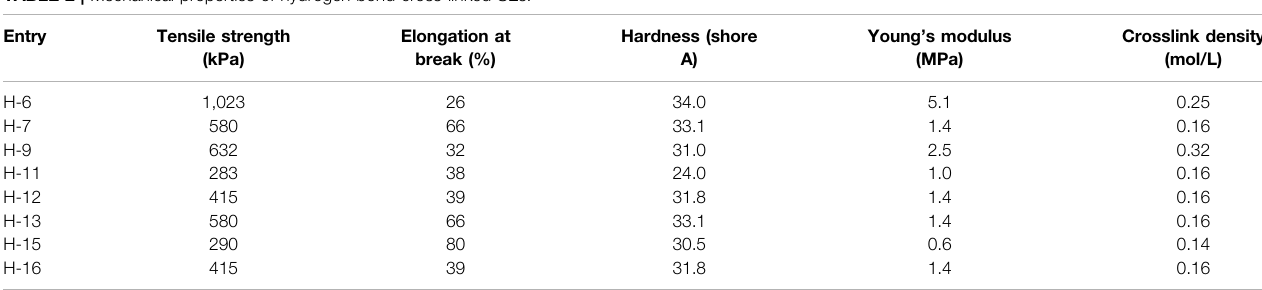
Table 3 . The fi rst variable is the heating time. When the